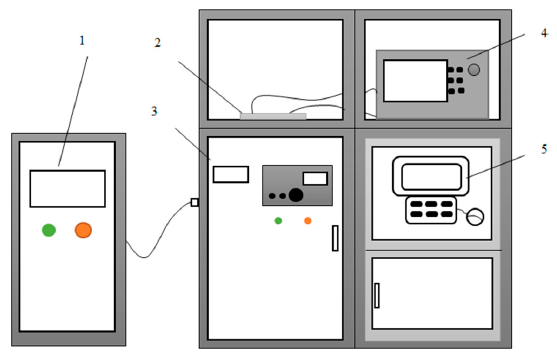
Figure 3. The structure diagram of dielectric constant measurement device (1-water cooling system, 2-reaction system, 3-control system, 4-microwave network analyzer, 5-PC collection system).